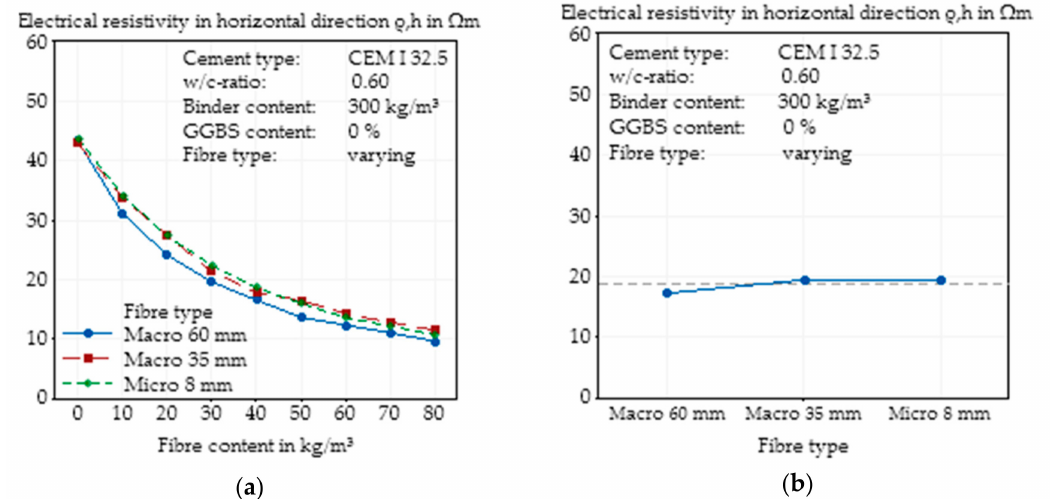
Figure 11. Effect of the steel fibre type (geometry) on the electrical resistivity in horizontal direction of SFRC as a function of fibre content ( a ) and main effect plot of the steel fibre type (geometry) on the electrical resistivity in horizontal direction of SFRC calculated by Minitab ( b